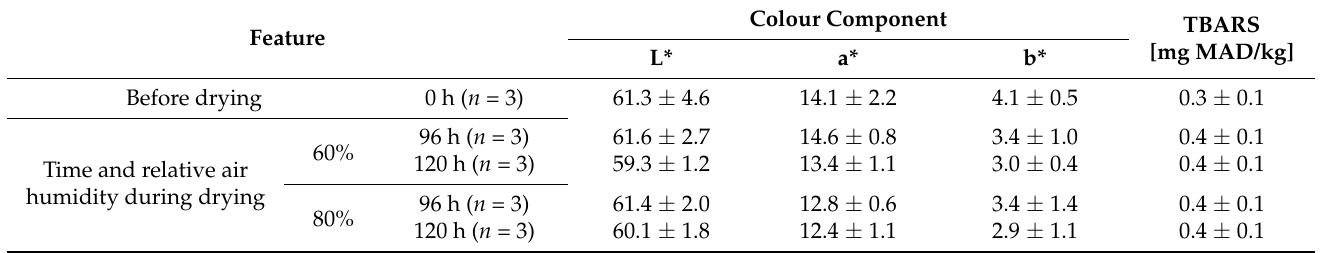
Table 6. Colour components L*, a*, b* and TBARS index of KSS sausages (mean ± standard deviation).